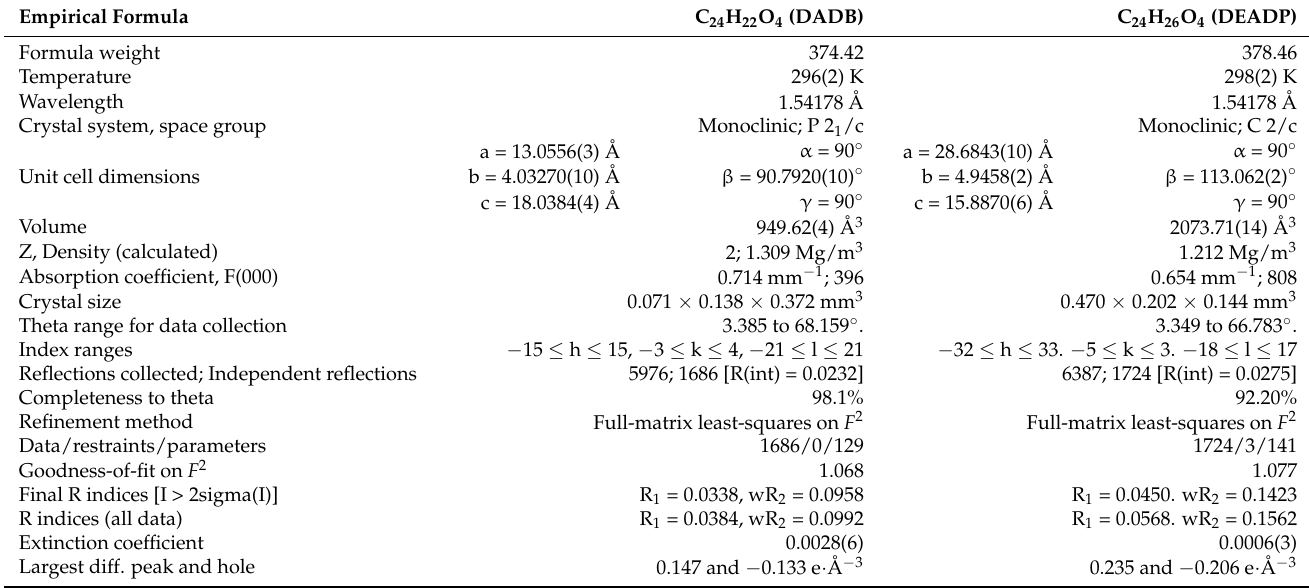
Table 1. Crystal data and structure refinement for DADB and DEADP.